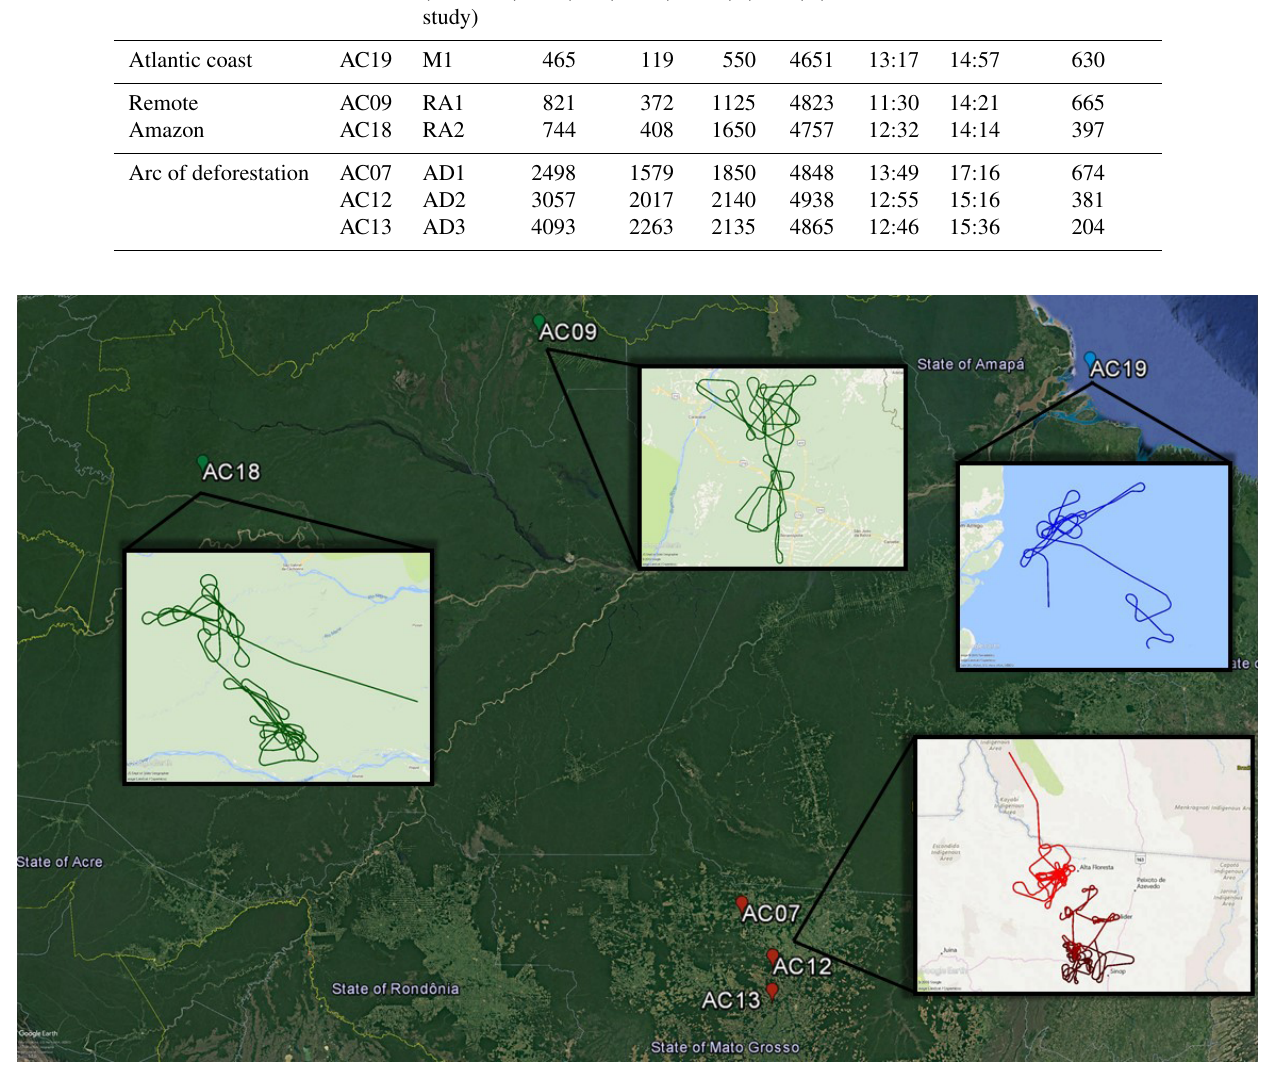
Figure 1. Profile locations and trajectories of interest to this study. The ACRIDICON–CHUVA research flights were labeled chronologically from AC07 to AC20. The labels in the figure reflect the respective flights where the cloud profiling section took place. The colors represent the different regions: green for remote Amazon, blue for near the Atlantic coast, and red for the arc of deforestation (different shades for